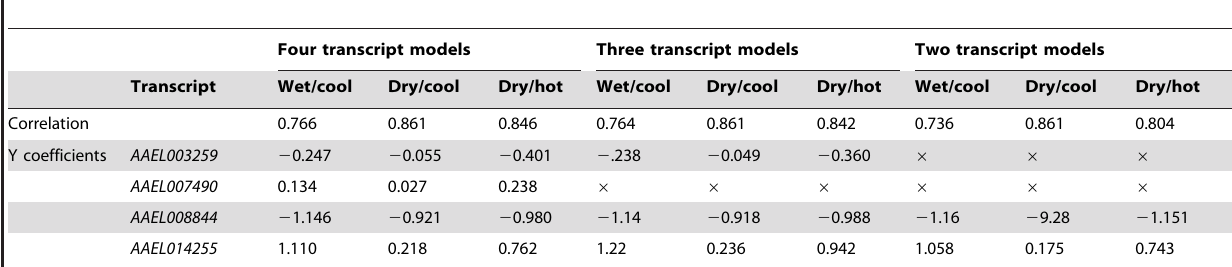
Table 3. Redundancy variate model parameters produced from Tri Nguyen sentinel cage mosquitoes maintained over three